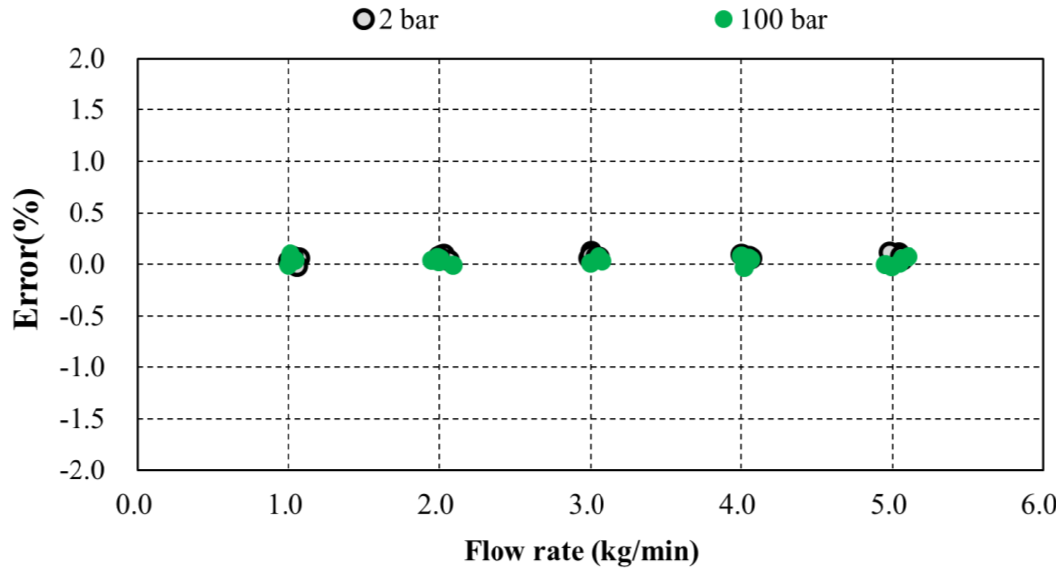
Figure 9. Measurement results of the Coriolis mass flowmeter at the inlet pressure condition of 2 bar and 100 bar.